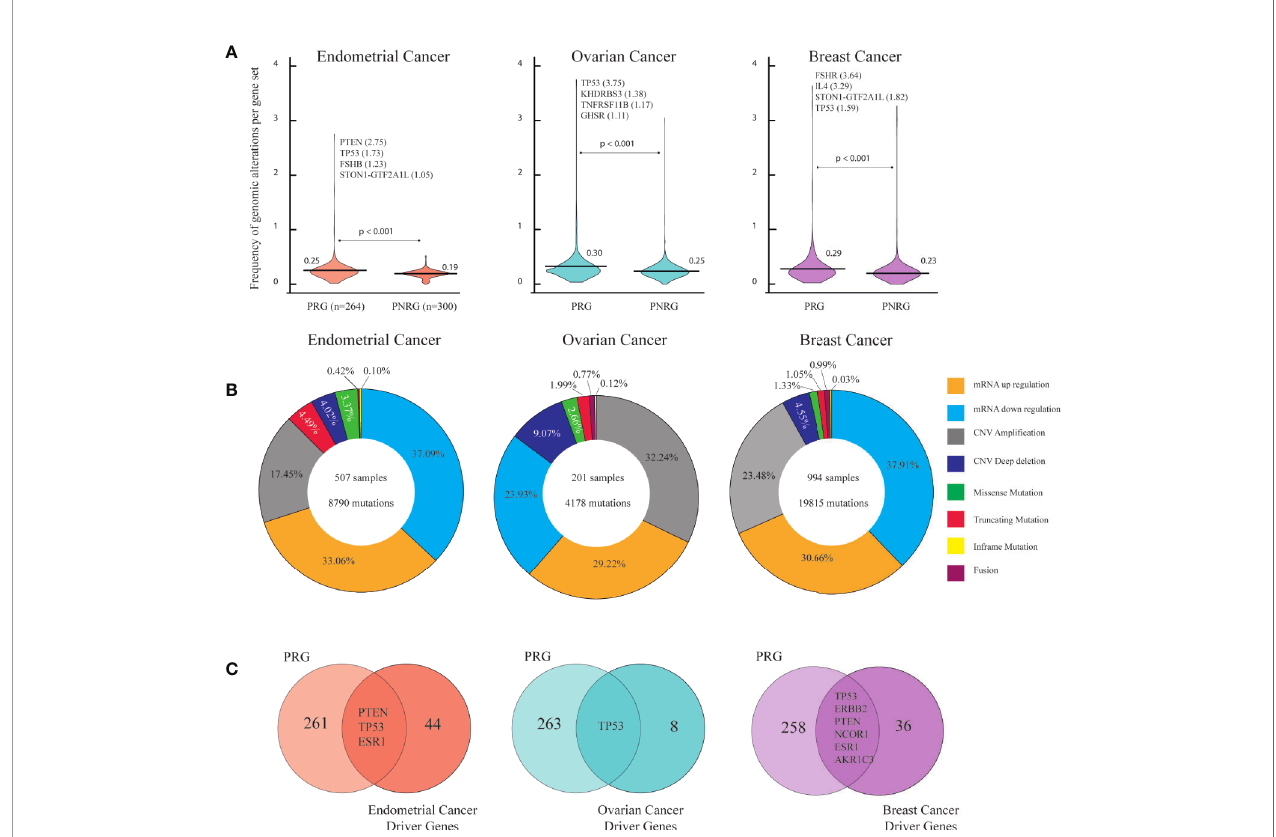
FIGURE 2 | Genomic alterations in endometrial, ovarian and breast cancer according to PanCancer Atlas. (A) Frequency of genomic alterations per gen set (associated PCOS genes (PRG [n=264]) and not associated PCOS genes (PNRG [n=300]) in each cancer type. Mann-Whitney U test with signi fi cant level of p < 0.05. (B) Percentage of genomic alterations types in each cancer type. (C) Identi fi cation endometrial, ovarian and breast cancer driver genes found in the list of more mutations in all race categories, except for Black or African American. In OC, TP53 was by far the most altered gene in all race categories. In BC, FSHR was top hit in Asian, Black or African American, and White, whilst ERBB2 in American Indian or Alaska Native ( Supplementary Table 11 ).